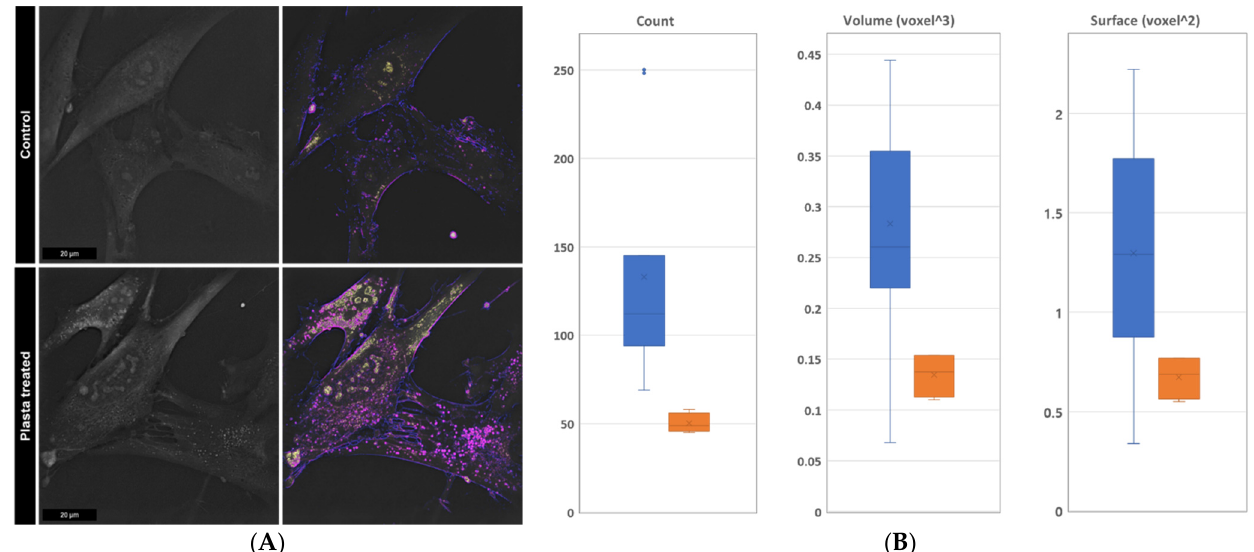
Figure 4. Morphology and intracellular structures observed by holotomographic microscopy. ( a ) Live-cell morphologies (left) and digitally stained subcellular structures (right, lipid droplets in pink) showed enhancement on NTAPP-treated surfaces (lower), compared to untreated controls (upper). ( b ) Lipid droplet count, volume, and surface area per cell were elevated on NTAPP-treated (blue) surfaces, compared to untreated controls (orange).